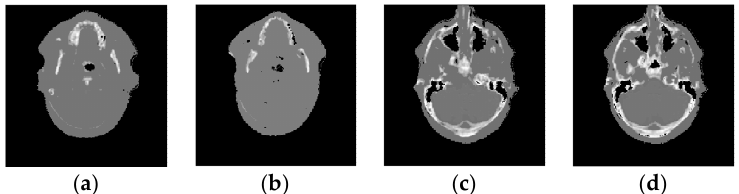
Figure 4. The patient head data referred to dental anatomical regions (from left to right), such as: ( a )–Upper jaw region (at slice #68), ( b )–Lower arch (at slice #52), ( c )–Mid-facial region (at slice #108), ( d )–Temporomandibular joint region (at slice #112).